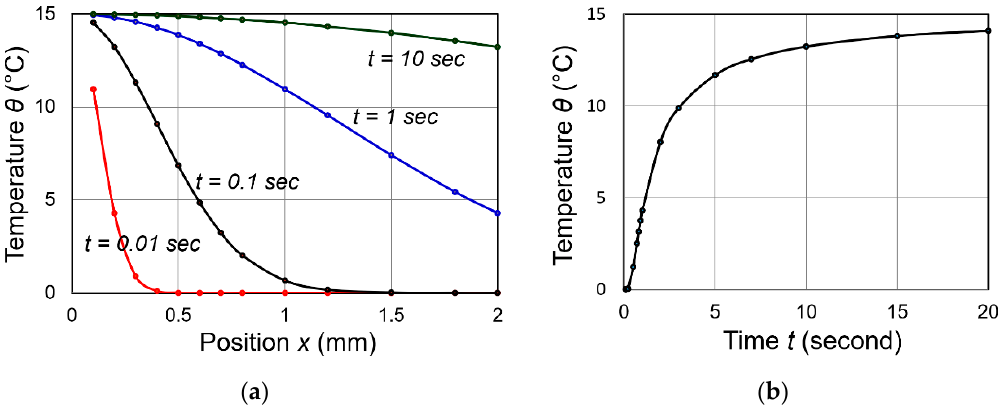
Figure 7. ( a ) temperature distribution profiles as a function of position x for various time lapses, and ( b ) temperature change with time at the position x = L .